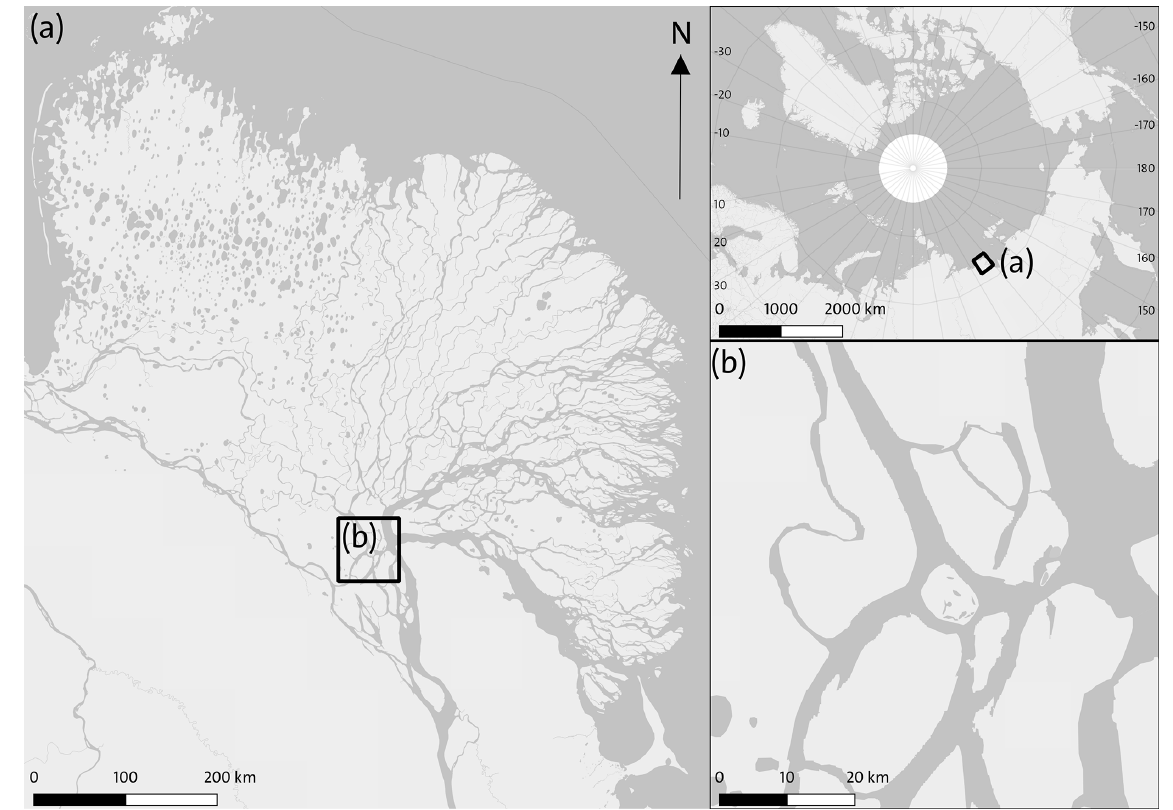
Figure 1. Location of Samoylov Island (center of b ) in the Lena River delta (a) . Map data from OpenStreetMap contributors, under Open Database